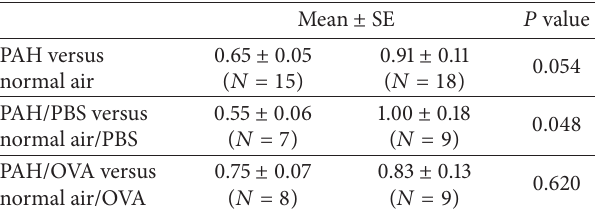
𝑁 refers to the number of mice per group. Values were normalized by setting a mean expression level from the normal air/OVA group and comparing values with the other groups. PAH exposed mice exhibited lower 𝛽 2 AR gene expression than that of normal air exposed mice, regardless of sensitization ( 𝑃 = 0.054 , two-tailed 𝑡 -test). Differences in gene expression appeared more pronounced among the nonsensitized mice ( 𝑃 = 0.048 , two-tailed 𝑡